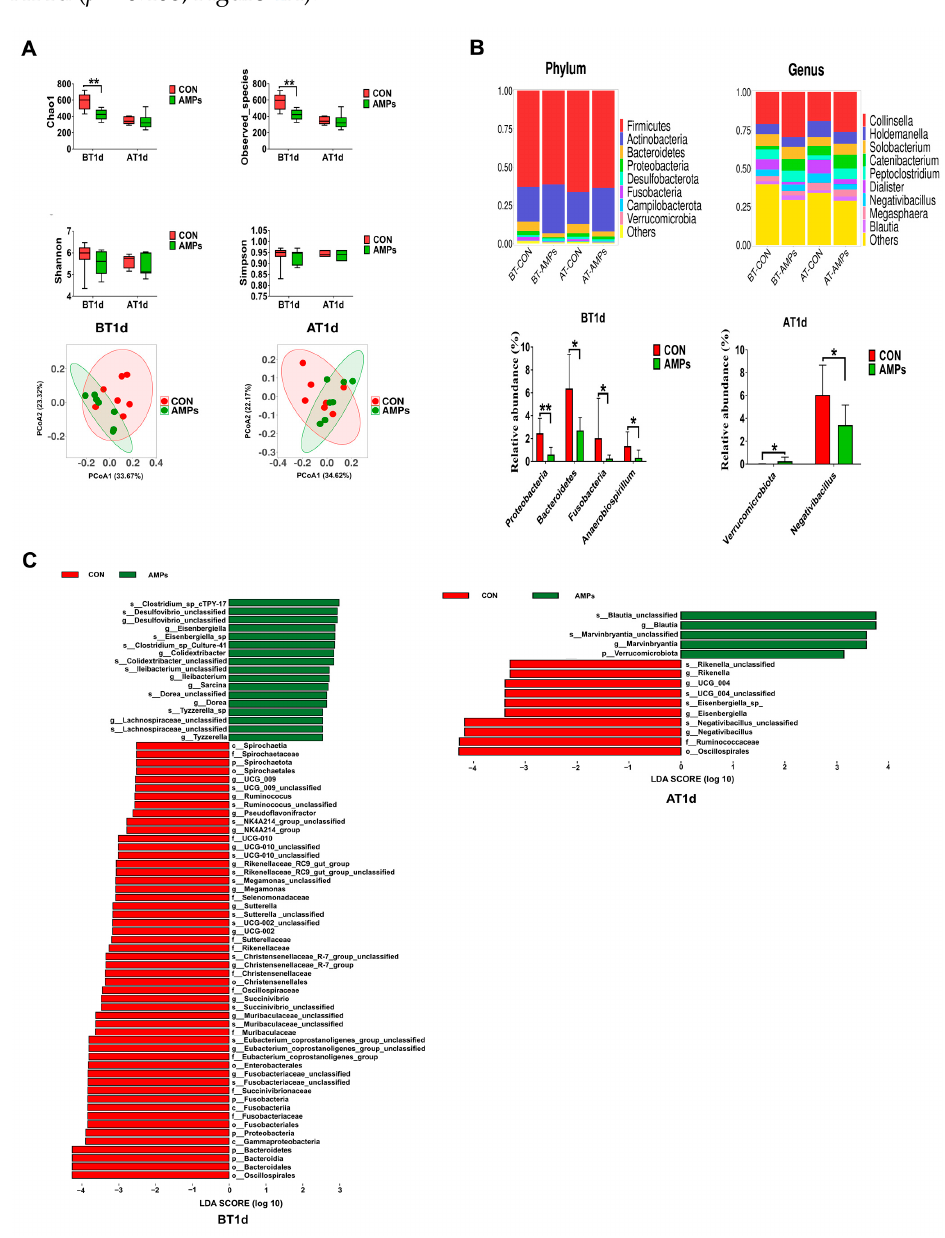
Figure 4. Effect of AMPs on fecal microbial. α -diversity and principal coordinate analysis (PCoA) based on weighted UniFrac distances ( A ); predominant fecal microbial communities ( B ); the linear discriminant analysis effect size (LEfSe) analysis identified gut bacterial biomarkers ( C ). Symbol (*) indicates statistically significant differences between two groups (* p < 0.05 and ** p < 0.01). BT1d, 1 day before transportation; AT1d, 1 day after